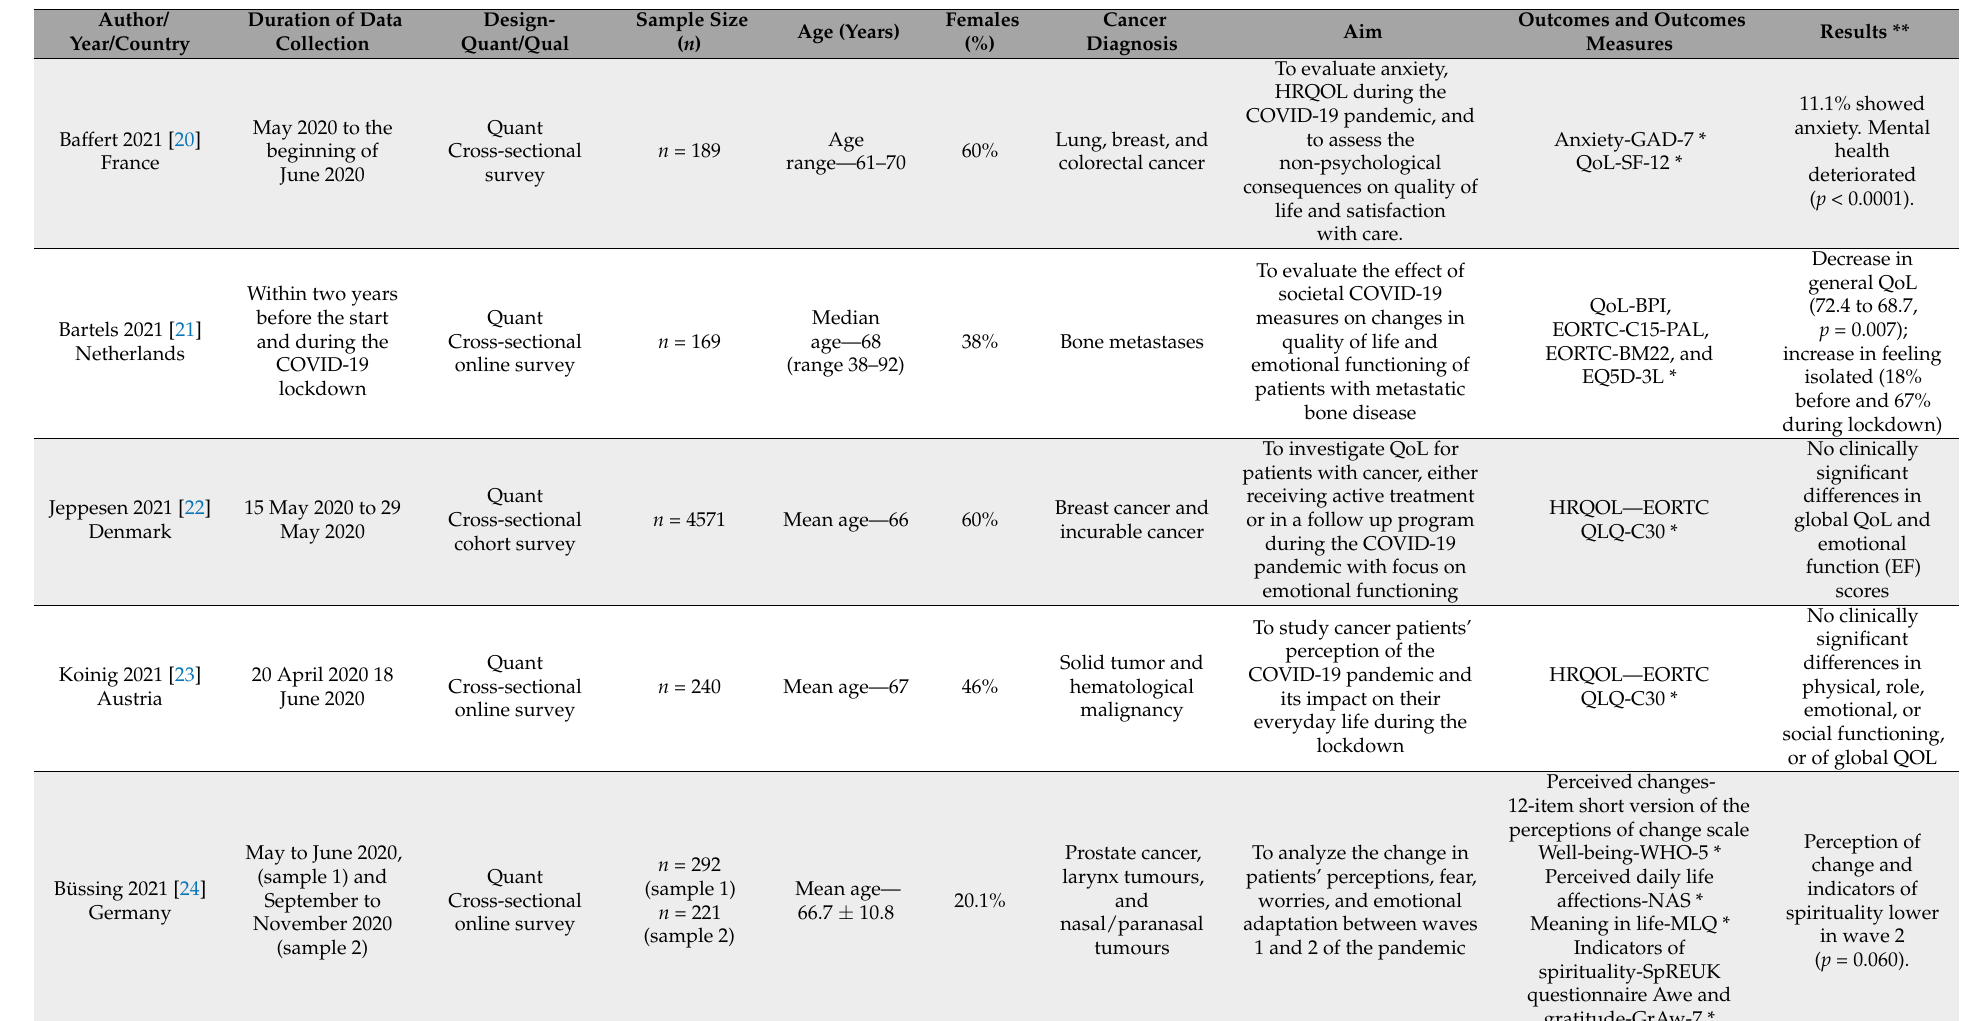
Table 1. Description of the study characteristic, participant details, objective, and